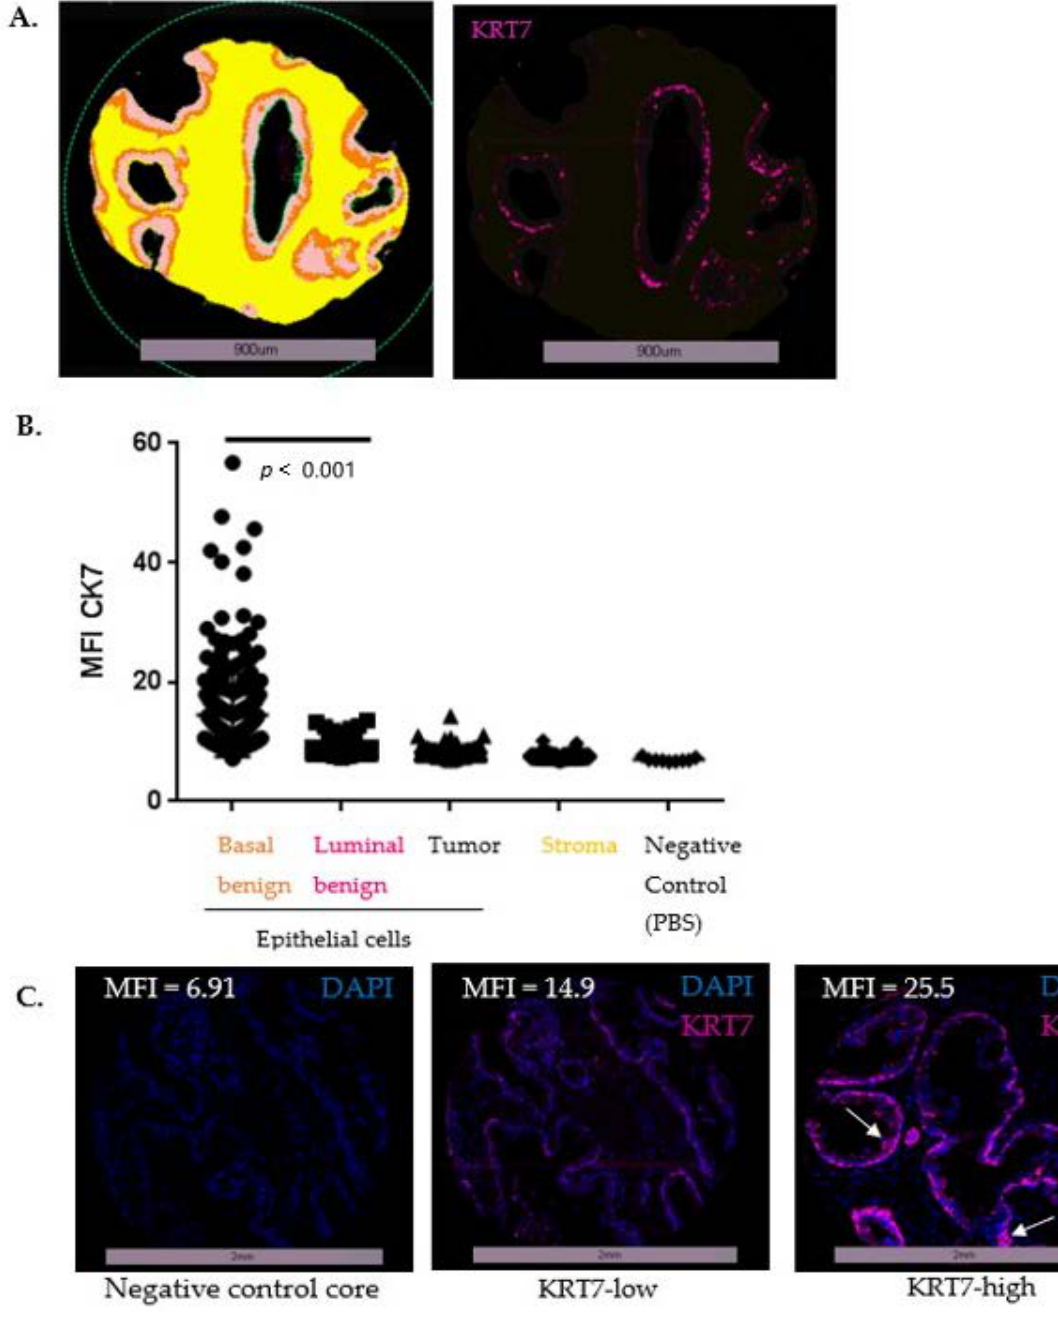
Figure 4. Characterization of KRT7 expression in stroma and epithelium from benign and tumoral glands. ( A ) Detection of KRT7 IF staining in basal cells from benign glands. KRT7 (detected using KRT7 OV-TL 12/30) was mainly expressed in the basal compartment of benign glands. ( B ) Quan- tification of KRT7 expression in each tissue compartment. Mean fluorescent intensities (MFI) were quantified by VisiomorphDP software and normalized using the ratio of the whole core. For each patient, expression levels were calculated using the average mean of two cores. ( C ) Examples of KRT7-low and KRT7-high staining in epithelial cells of benign glands adjacent to the tumor. Negative control core corresponded to the quantification of MFI in cores when IF was performed with only secondary antibodies (Cy7 antibody anti-mouse). KRT7-low corresponded to cores with intensity under the 80th percentile in basal benign cells (MFI < 17.56) and KRT7-high was established at an intensity higher than the 80th percentile (MFI > 17.56) in basal benign cells, after quintiles evaluation of MFI. Supra-basal staining is indicated with arrows. Magnification 20 ×